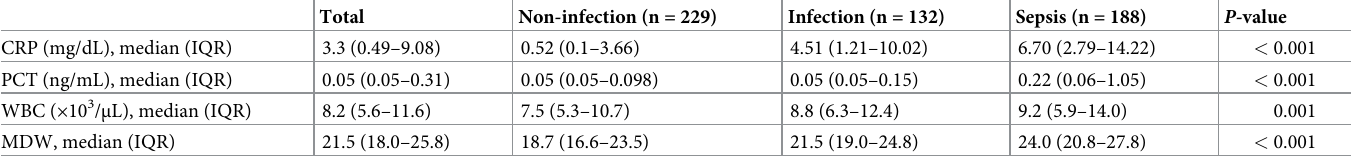
Table 2. Comparison of biomarker levels according to Sepsis-3